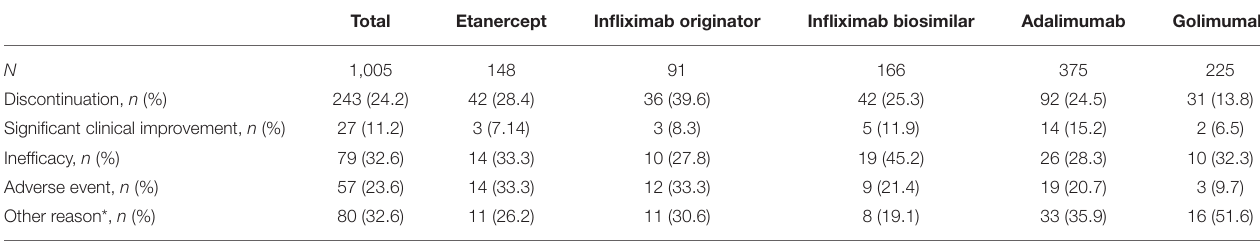
TABLE 3 | Reasons for discontinuation.